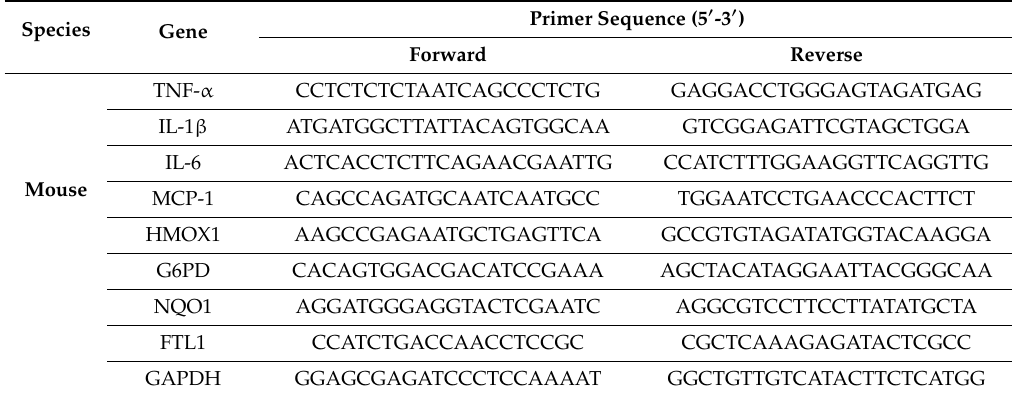
Table 1. Primer sequences for